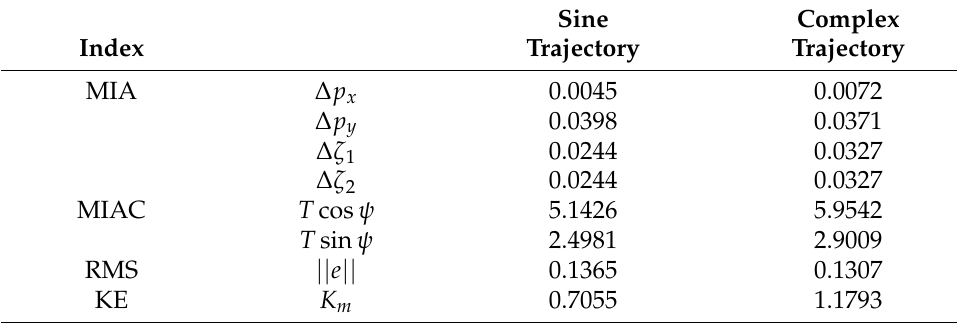
Table 2. Performance for IQV controller (with friction).